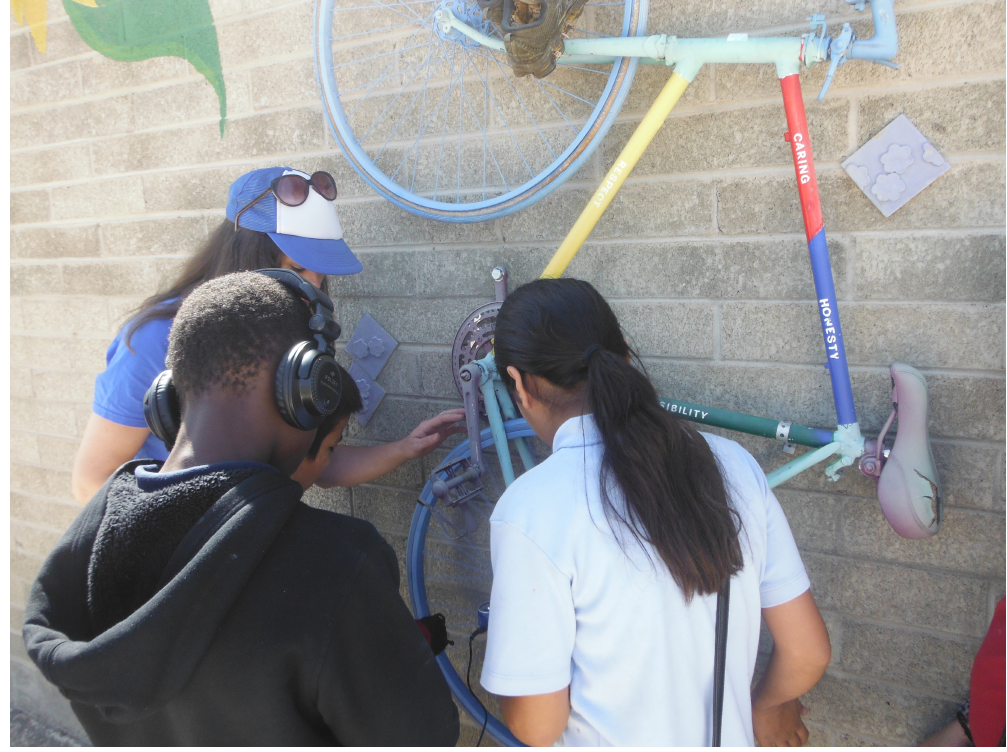
Figure 3. Children from Free Arts recording sounds from the site using portable sound